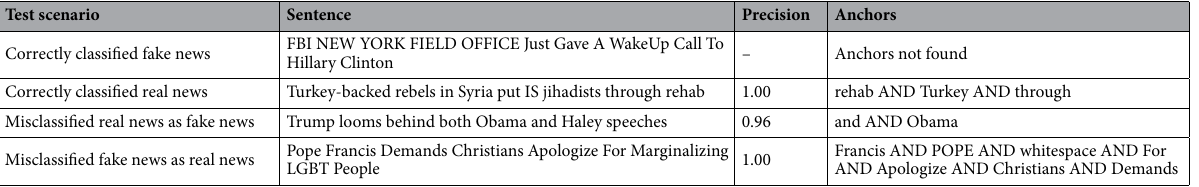
Table 3. Anchors explanations for the four test scenarios—BERT-based